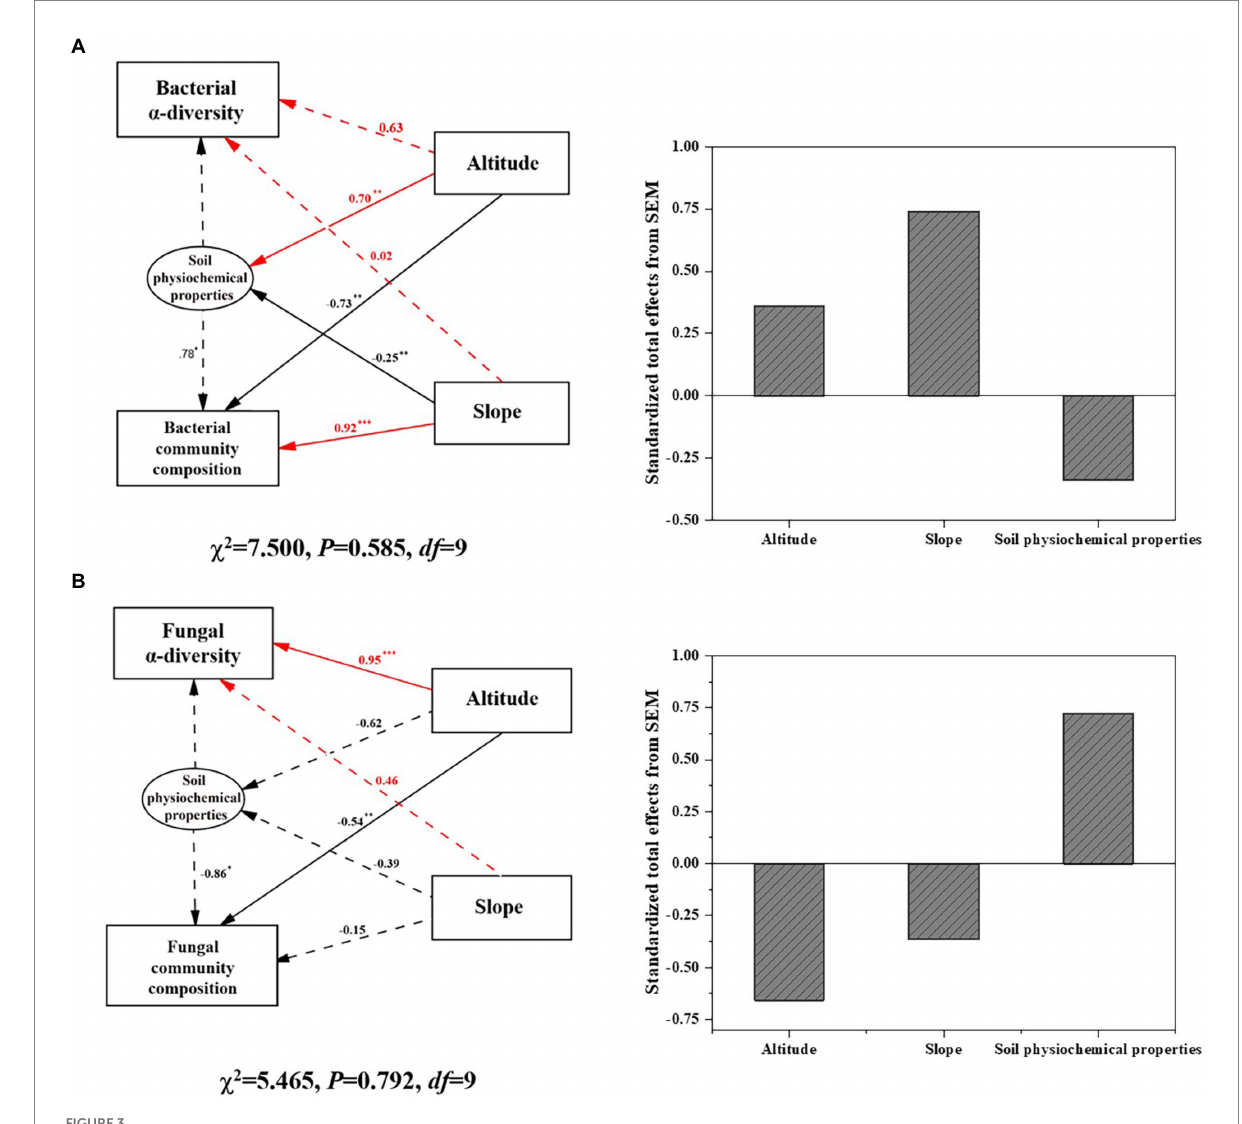
FIGURE 3 Structural equation model (SEM) illustrating the direct and indirect effects of altitude, slope, and soil physiochemical factors on (A) bacterial community, and (B) fungal community on Mount Segrila. Arrows depict casual relationships: red lines indicate positive effects, and black lines indicate negative effects. Continuous and dashed arrows indicate significant and nonsignificant relationships, respectively. Significance levels are denoted with * p < 0.1, ** p < 0.01, *** p < 0.001. Standardized total effects (direct plus indirect effects) derived from SEM were